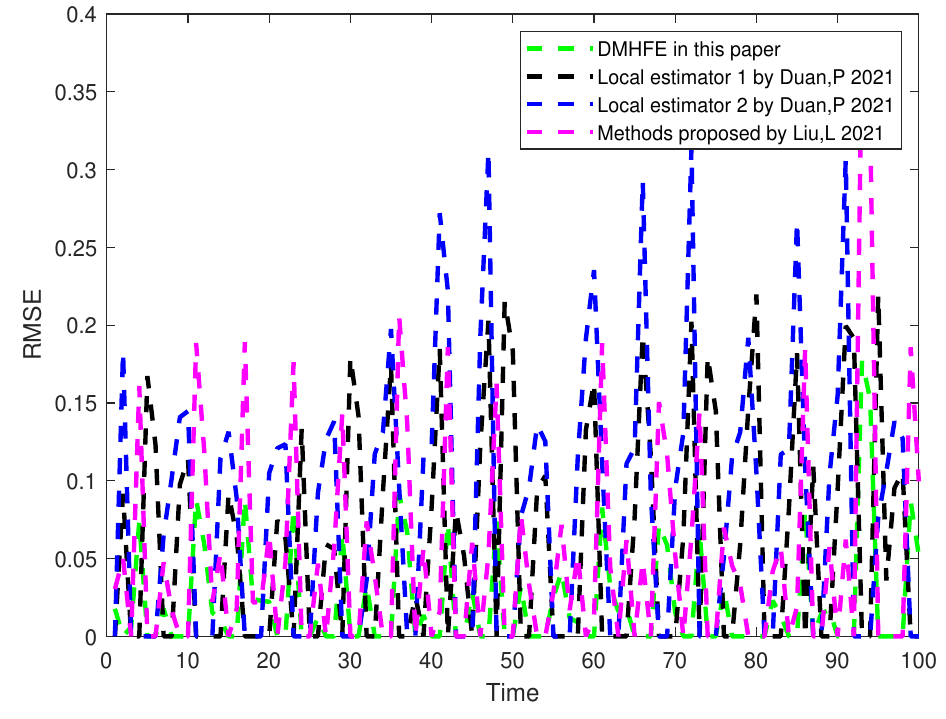
Figure 4. Comparison of RMSE